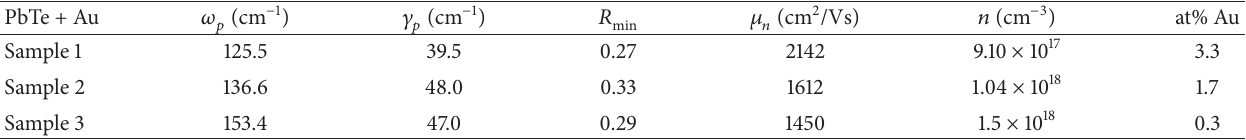
Table 1: Calculated parameters for PbTe doped with Au.